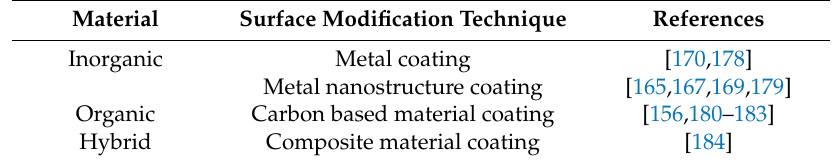
Table 3. Coating materials and surface modification techniques for enhancing electrode